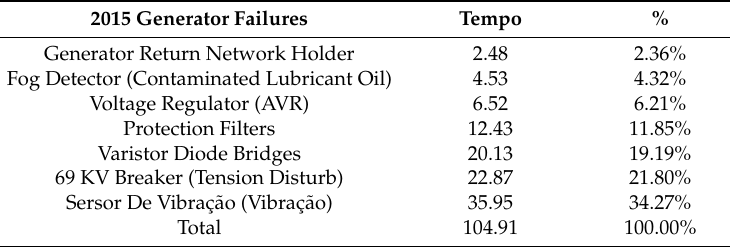
Table 4. Calculation of Mean Time Between Failure (MTBF) and Average Time to Repair (MTTR),